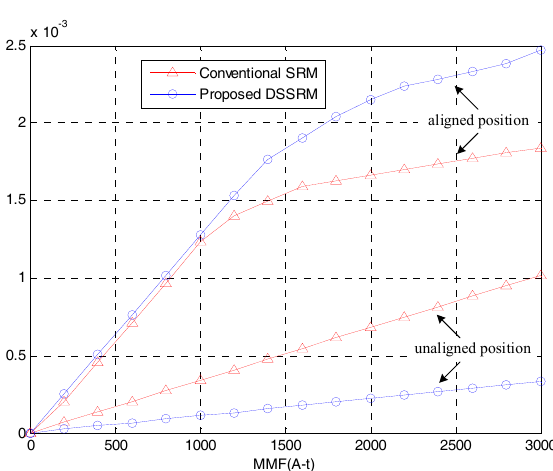
Figure 25. Flux linkages of conventional SRM and proposed DSSRM at aligned and unaligned positions.